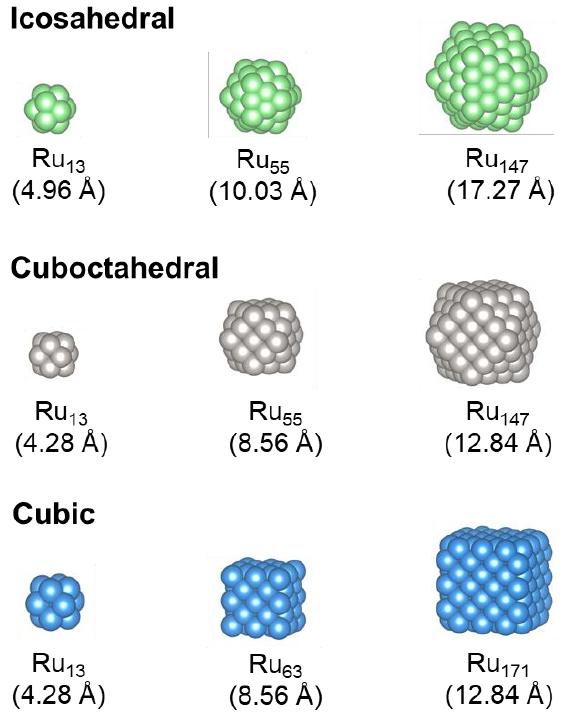
Figure 1. Stable Ru fcc nano-dots for the icosahedral, cuboctrahedral and cubic shapes, at each of the three sizes studied; calculated with the interatomic potentials for Ru [34,35] utilised in OpenMD [32].